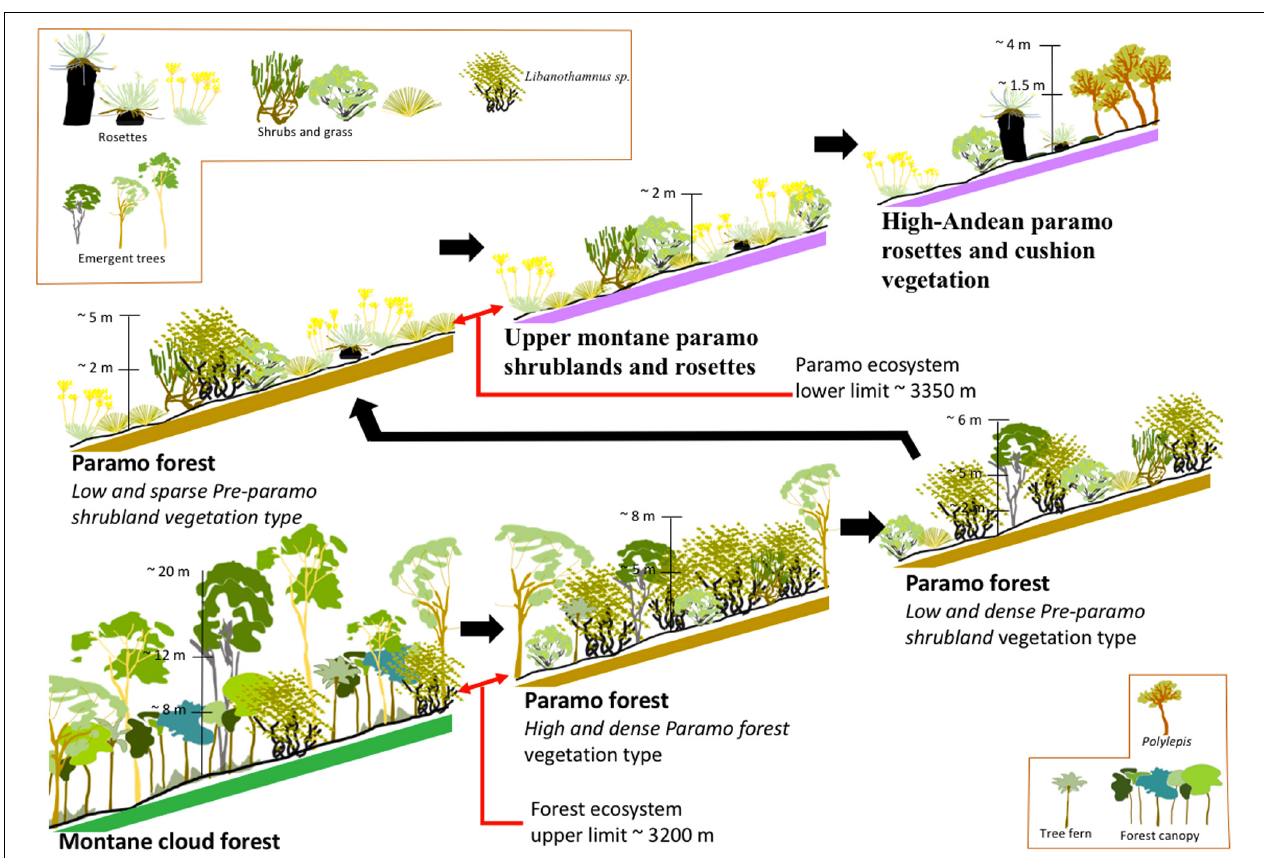
FIGURE 7 | Synthesis of the transition and displacement of the different ecosystems and vegetation types for the treeline zone in Cordillera de Mérida, Venezuela. It presents six profiles representing the four main ecosystems and three vegetation types for the Páramo forest ecosystem. Each profile shows the vegetation structure-based on the primary plant life forms, height of the canopy, and representative plants. Slope ∼ 30% is